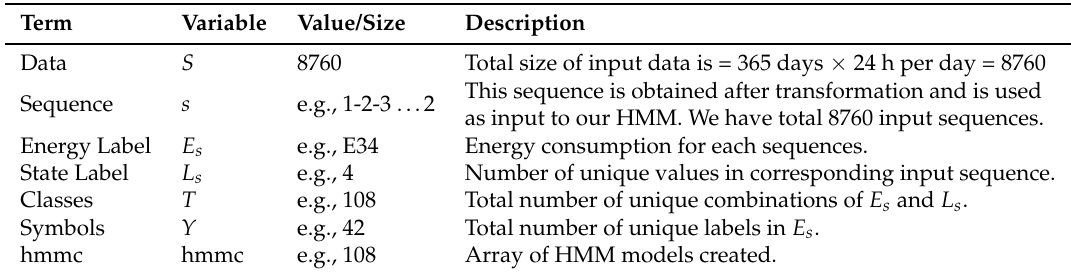
Table 1. Brief description of terms used in our